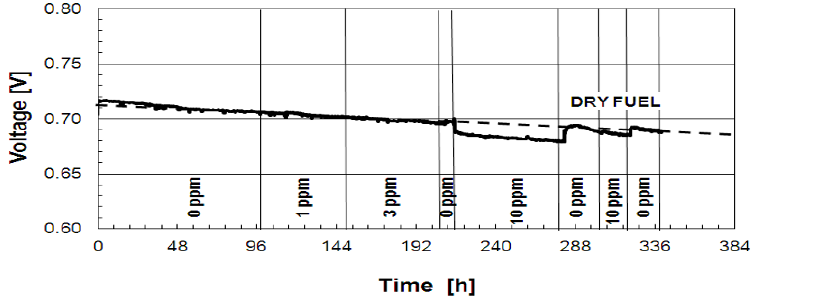
Figure 9. The effect of 1-10 ppm HCl on the SOFC cell performance at 250 mA cm -2 current density at 750°C for the fuel (50%H with 3% H